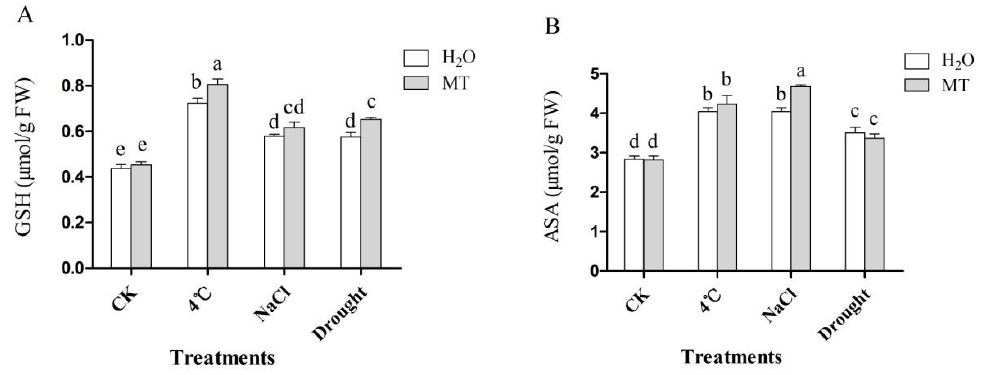
Figure 4. E ff ect of exogenous melatonin on non-enzymatic antioxidant in tea leaves at 48 h after abiotic stress treatment. ( A ) glutathione (GSH), ( B ) ascorbate acid (ASA). The tea plants were subjected to control (CK), cold stress (4 ◦ C), high salt (300 mM NaCl) and drought stress (200 g · L − 1 PEG) with di ff erent treatments (CK and 100 µ M melatonin). Data represent means ± SD of three replicate samples. Di ff erent letters indicate significant di ff erences according to Duncan’s multiple range test ( P < 0.05).